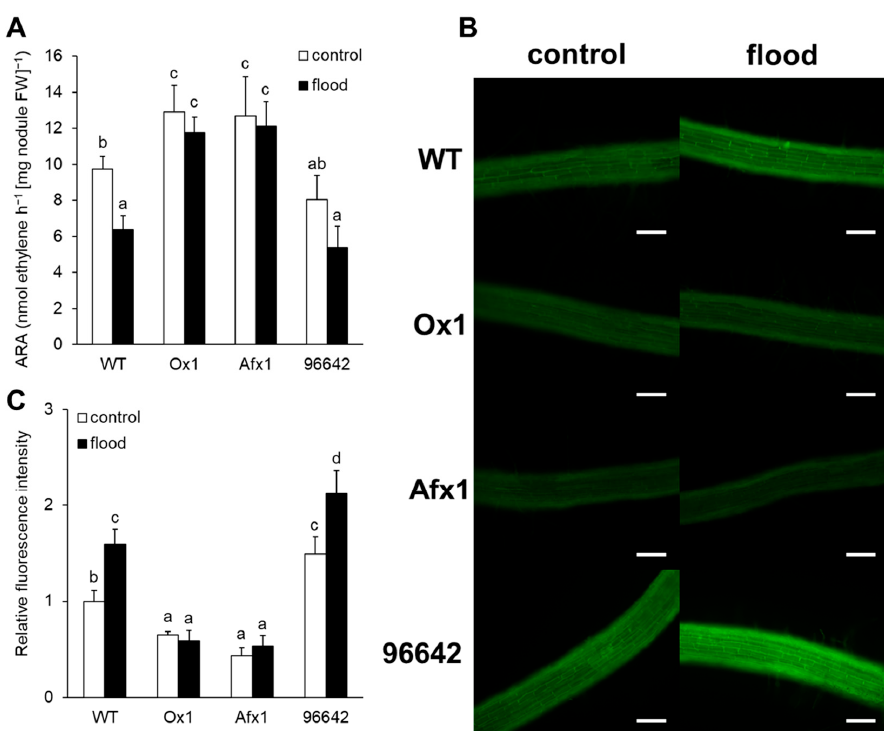
Figure 1. Nitrogenase activity and NO production in roots of the WT, Ox1, Afx1, and 96642 lines. ( A ) Nitrogenase activity (estimated as ARA) was measured in the flooded and unflooded (control) nodules and was expressed as ethylene produced per hour and mg nodule fresh weight. ( B ) Fluorescence imaging of NO production in roots with the DAF-FM DA probe. Scale bars, 100 μ m. ( C ) Quantification of fluorescence intensity in DAF-FM DA images. In A and C, values are means ± SE of nine biological replicates. Means denoted by the same letter do not differ significantly by Student’s t - test at p < 0.05.